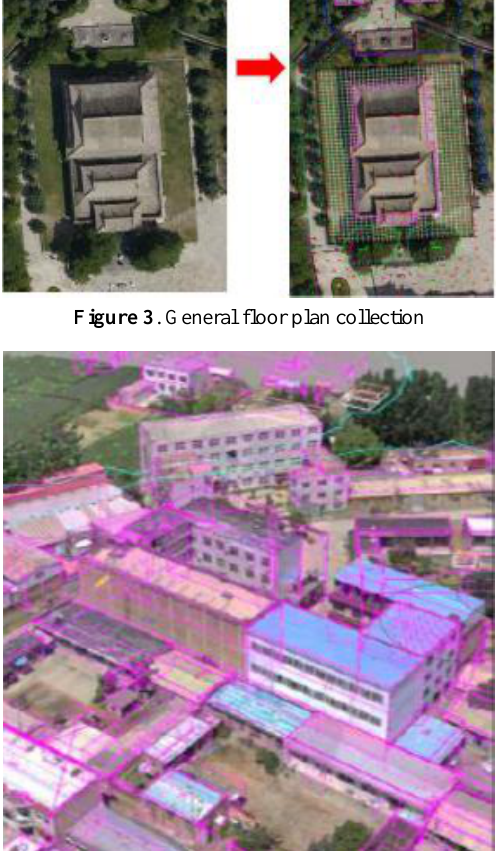
Figure 4 . Internal software